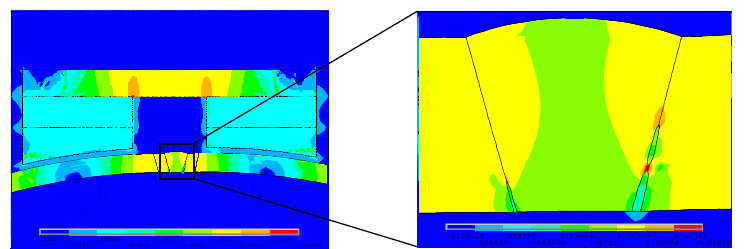
Figure 7. Magnetic induction intensity cloud diagram under 18.8186 MPa load step.